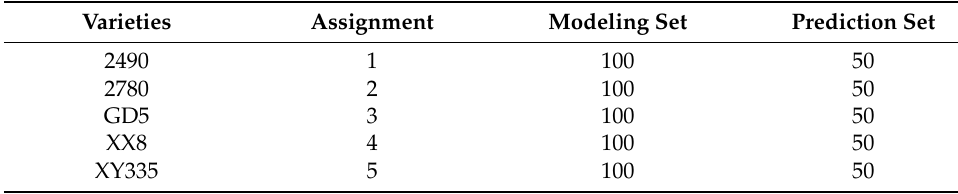
Table 2. Class value assignment and dataset split of different maize